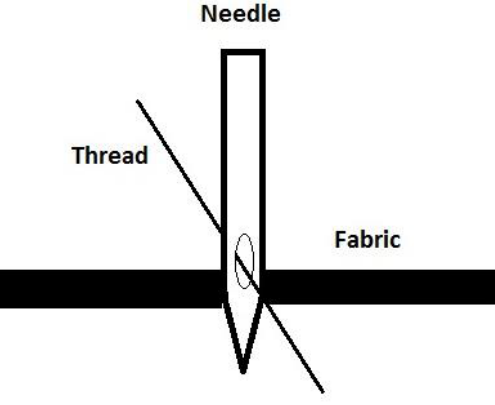
Figure 1. Sewing needle, thread, and fabric diagram [18].